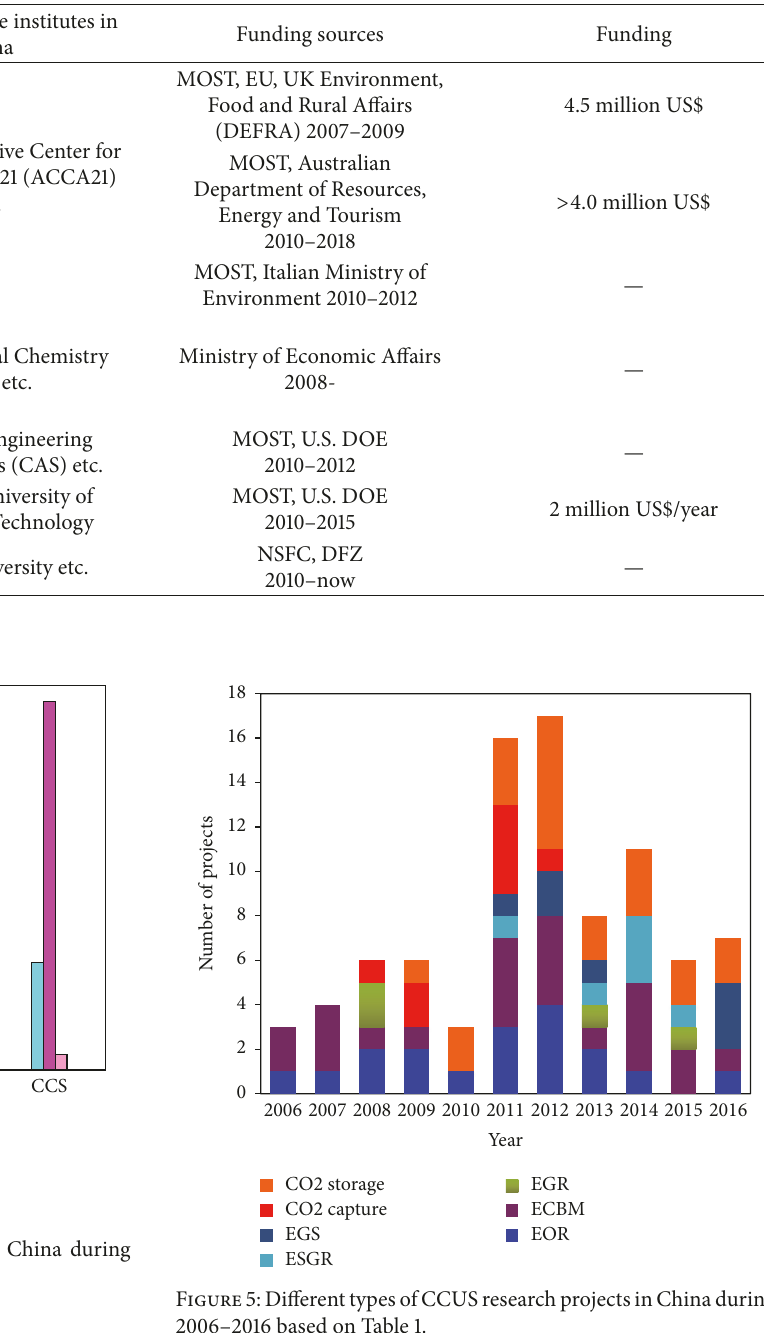
Table 2: China’s international collaboration on CCUS projects during 2005–2016.